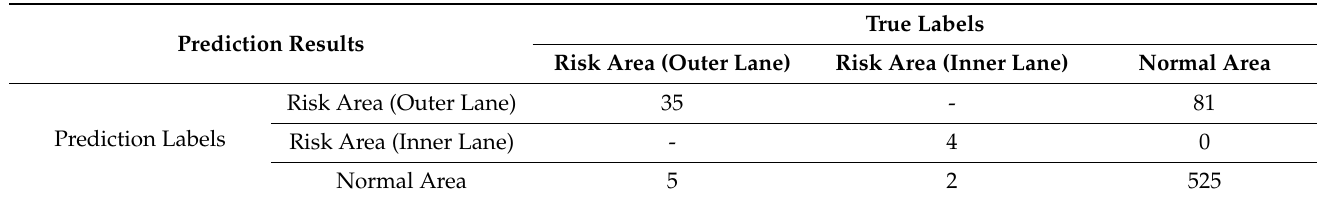
Table 3. Results of regional risk prediction model.